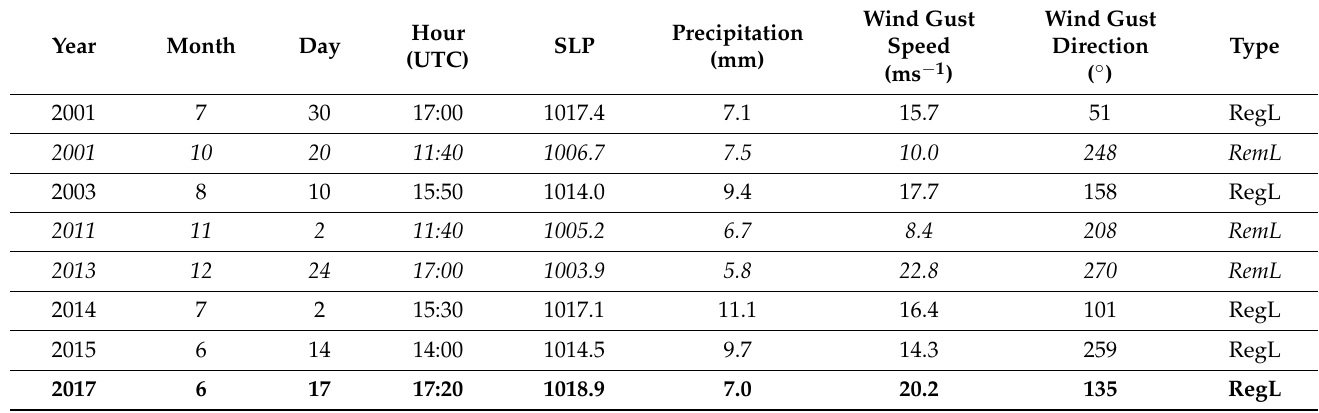
Table 1. List of the sea-level pressure surges recorded at the WS 570 (Castelo Branco), giving the year, month, day, and hour of occurrence, sea-level pressure (SLP) at peak precipitation, 10-min precipitation, wind gust speed, wind gust direction, and synoptic type (RemL or RegL, the former shown in italic font). The selected case study (17 June 2017) is highlighted in bold